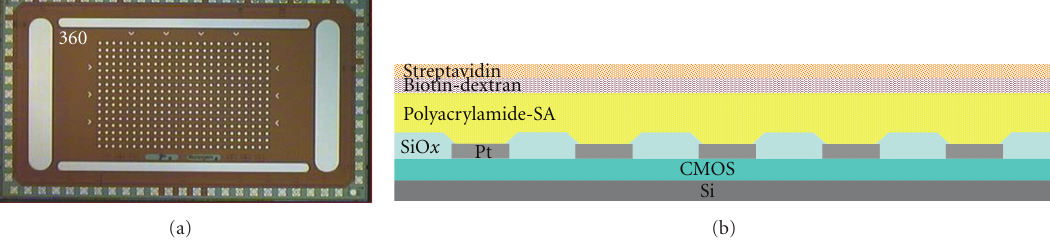
Figure 2: Images of the 400 site platinum electrode CMOS microelectronic array and a cross-section of the structure. The microarray is 4mm × 7 mm, and each microelectrode is 55 µ m in